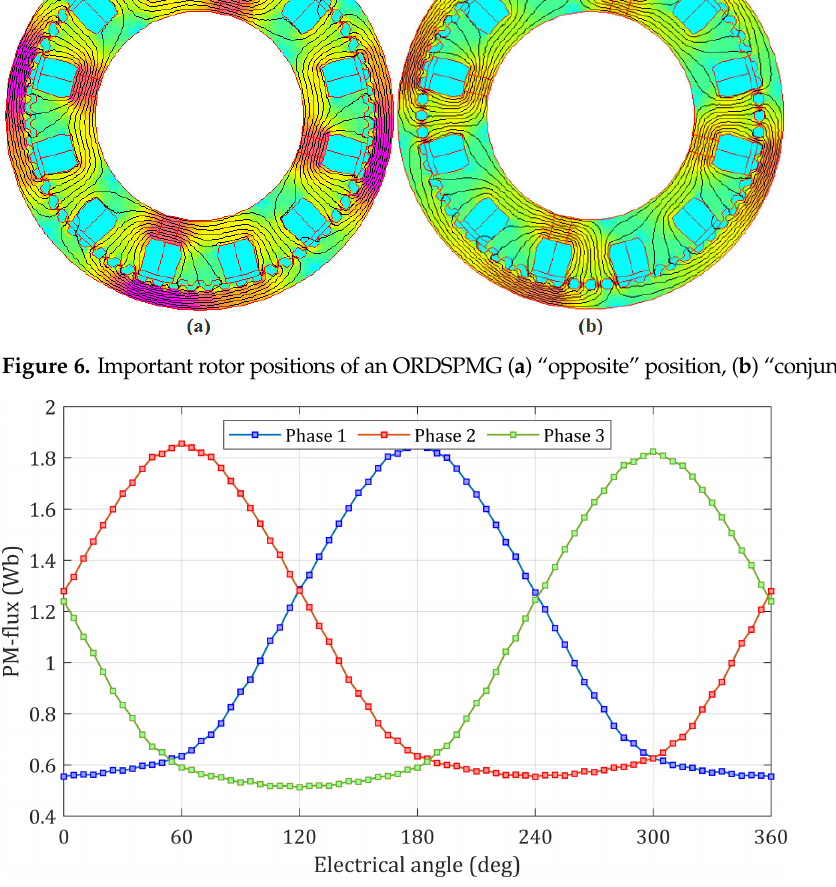
Figure 7. Permanent magnets flux vs. electrical